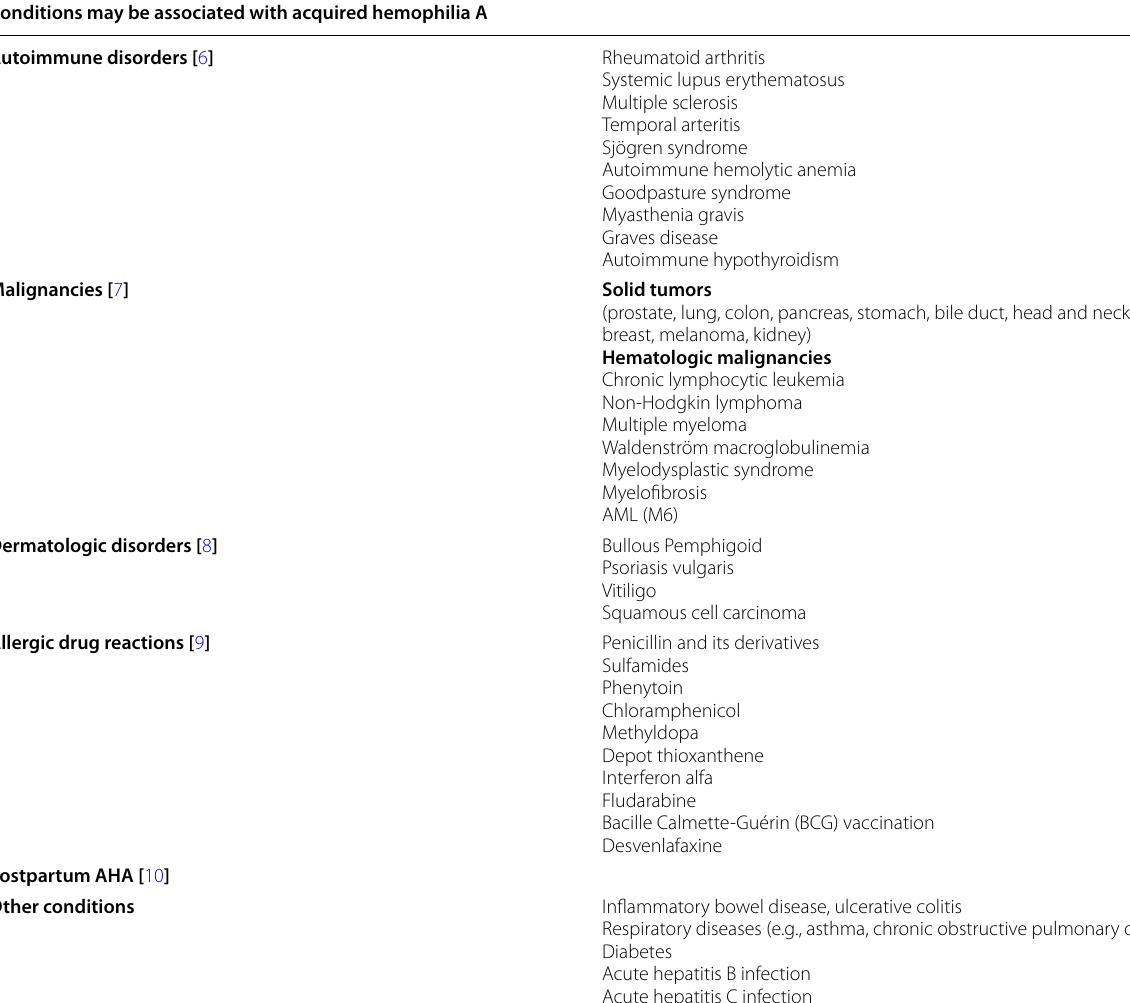
Table 2 Conditions may be associated with acquired hemophilia